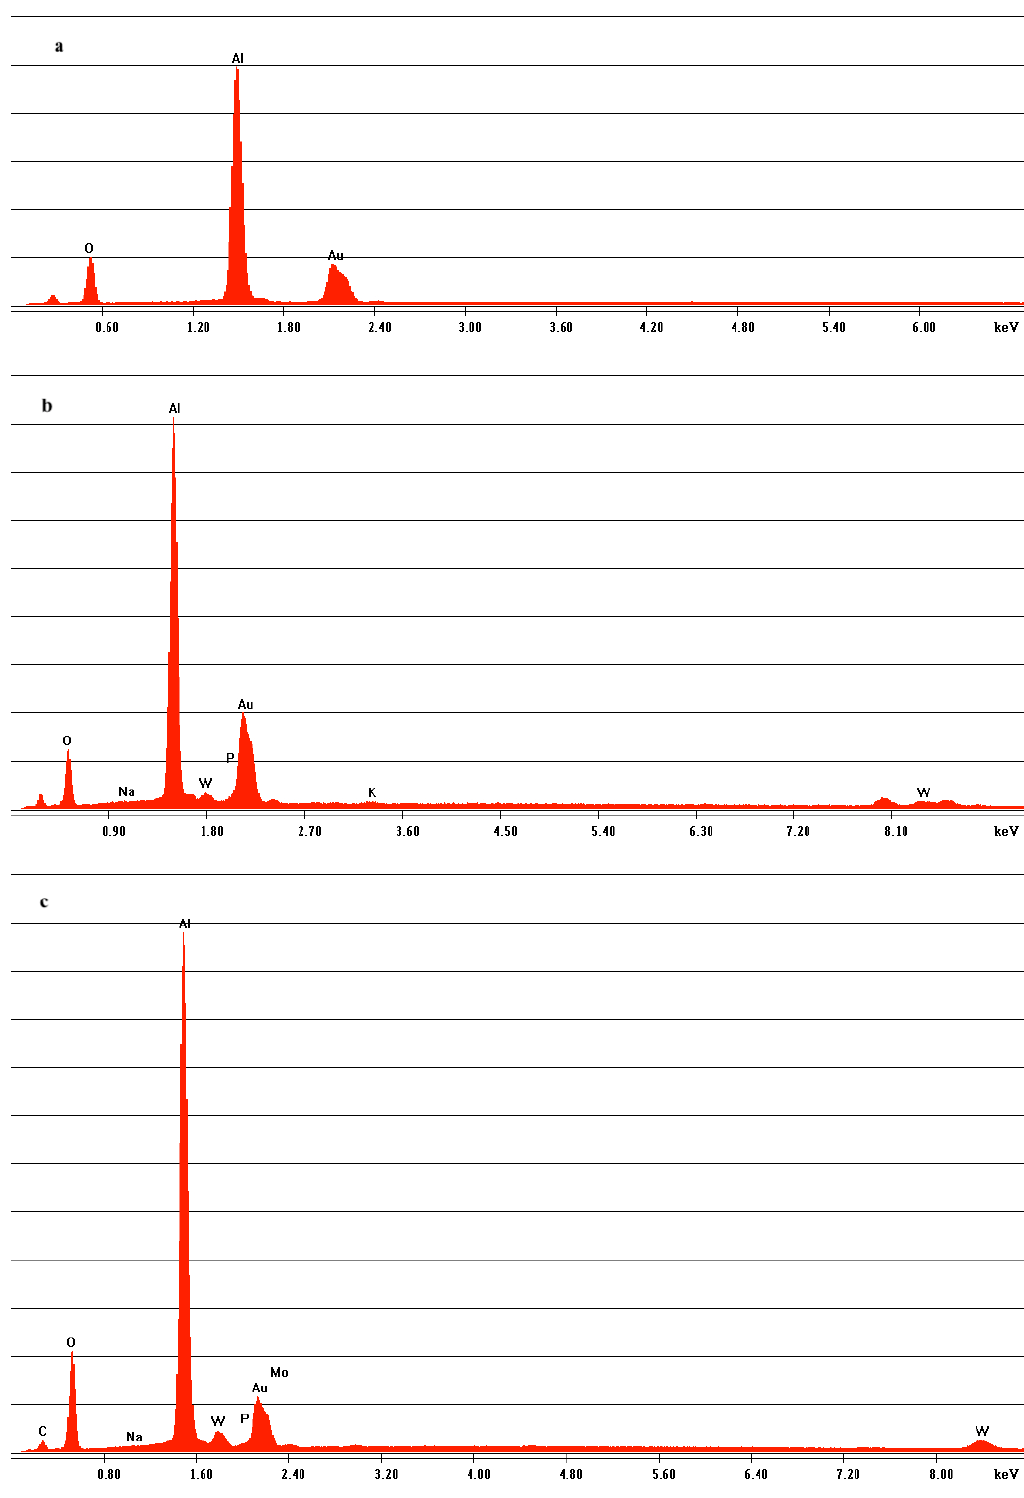
Figure 5. EDAX spectra of ( a ) Catalox Sba-90, ( b ) PWAl 2 O 3 , and ( c ) PWMoAl 2 O 3 .